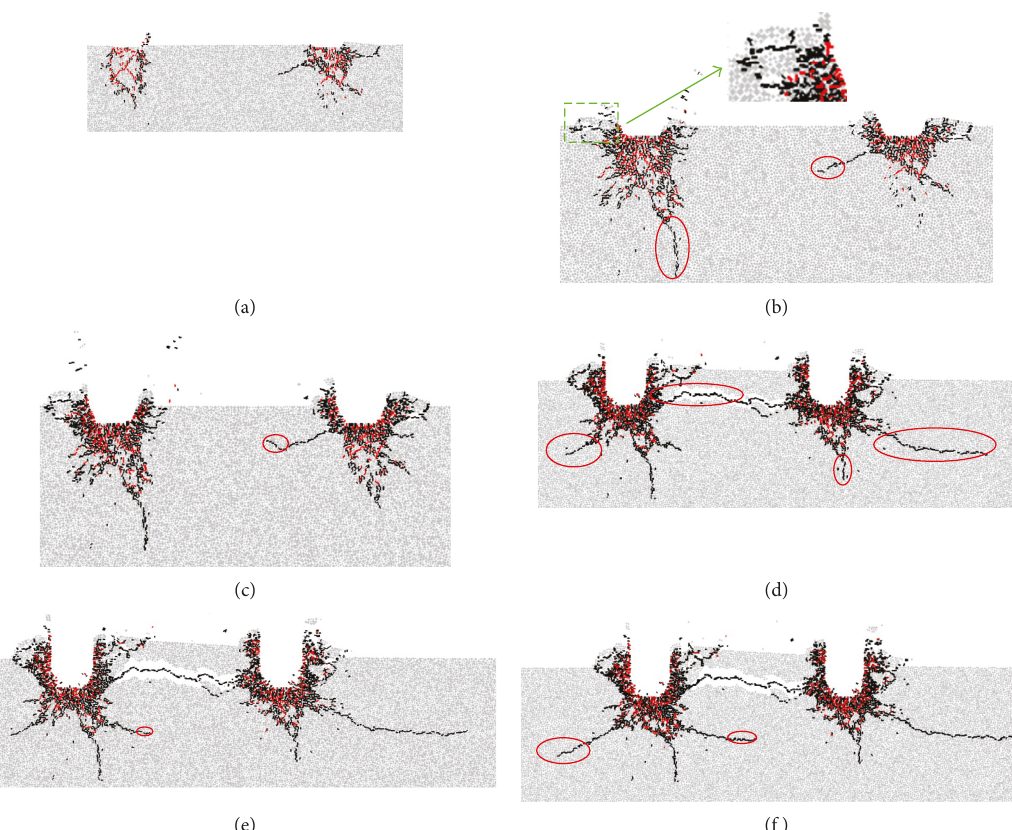
Figure 11: Crack propagation at peak and bottom points: (a), (b), (c), (d), (e), and (f ) are the crack propagation conditions at P1, B1, P2, B2, P3, and